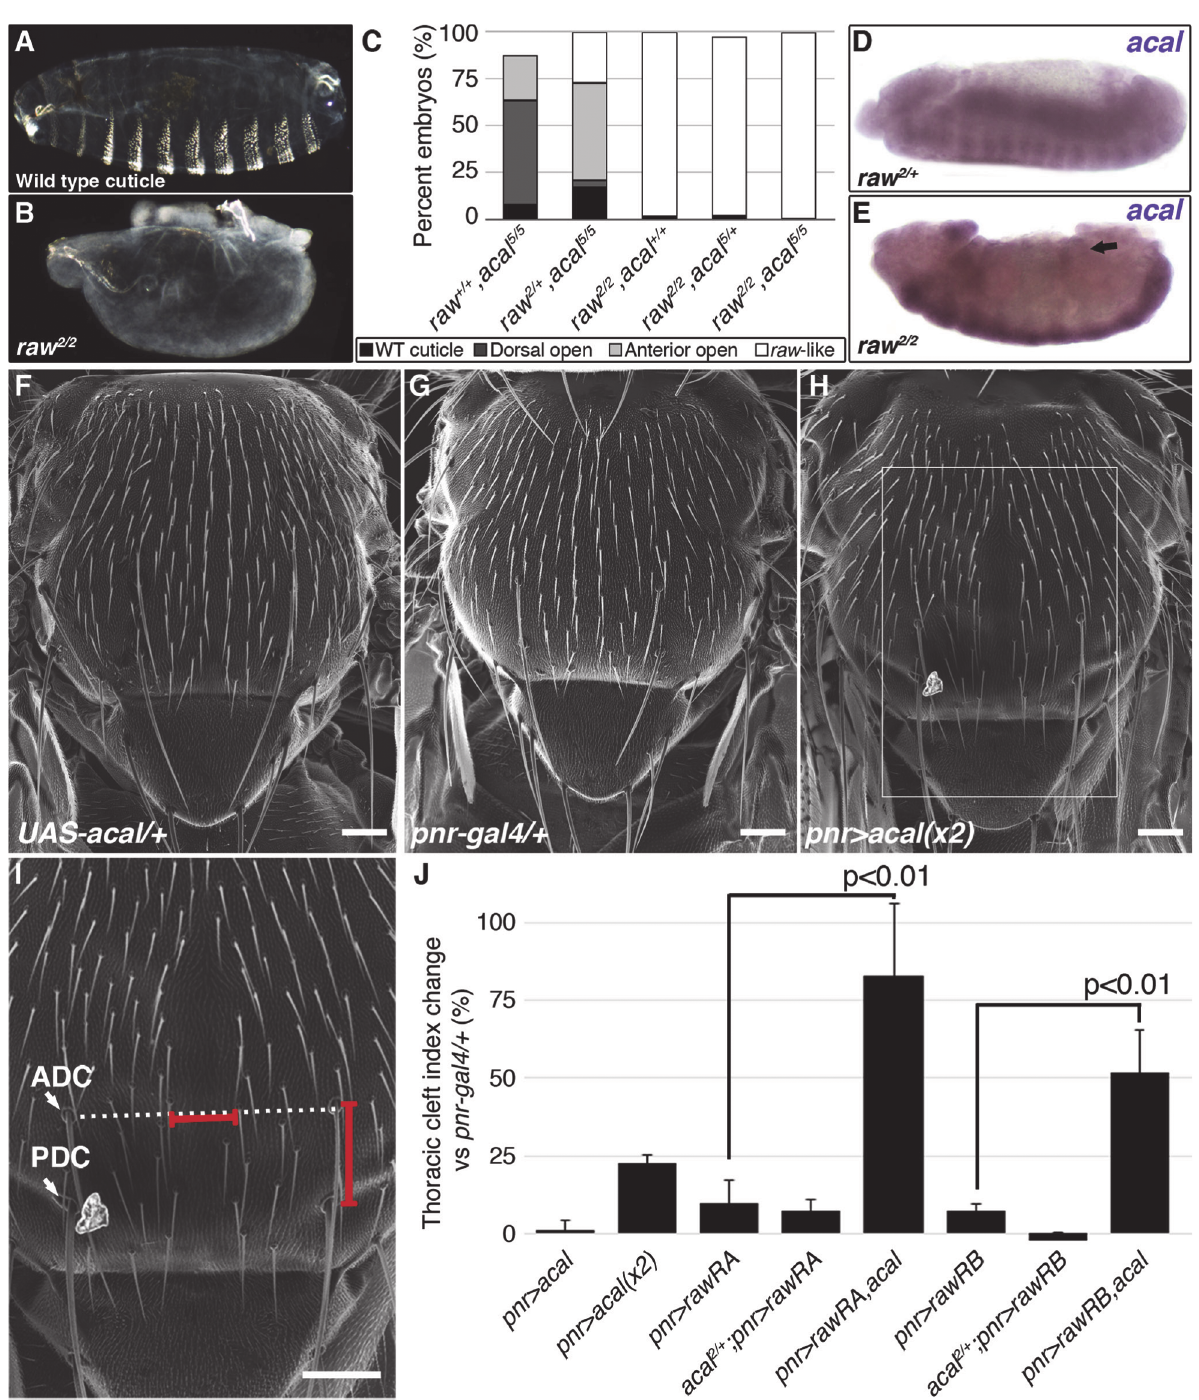
Fig 6. raw and acal act together to counteract JNK signaling. (A) Wild type cuticle. (B) Cuticle phenotype of raw mutant embryo. (C) Genetic interaction between raw 2 and acal 5 mutants. raw -like phenotype is depicted in (B). In raw +/+ ; acal 5/5 mutants a small percentage survives embryogenesis, and constitute the open space above the bar to amount to a hundred percent total. Number of animals analyzed: raw +/+ , acal 5/5 = 391, raw 2/+ , acal 5/5 = 139, raw 2/2 , acal +/+ = 366, raw 2/2 , acal 5/+ = 152, raw 2/2 , acal 5/5 = 208. Significance was assessed with chi square tests. (D-E) acal in situ hybridization in raw 2 mutants (n = 45; D) and heterozygous siblings (n = 106; E). Arrow in (E) points to decreased acal expression in the lateral epidermis. See also S5 Fig. (F-I) Scanning electron micrographs of dorsal views of adult thoraces, anterior is up. Scale bars are 100 μ m. (F) UAS-acal/+ control, (G) pnr-gal4/+ control, and (H) over-expression of two UAS-acal copies. The white box in (H) is amplified in (I), depicting distances (red lines) measured to determine the thoracic cleft index, using anterior dorso-central (ADC) and posterior dorso-central (PDC) bristles as references (see Materials and Methods). (J) Percentage change of thoracic cleft index for different experimental conditions. Mean of 15 flies +/ − SEM. Significance was calculated using ANOVA and Bonferroni correction. doi:10.1371/journal.pgen.1005138.g002 PLOS Genetics | DOI:10.1371/journal.pgen.1005138 April 10,